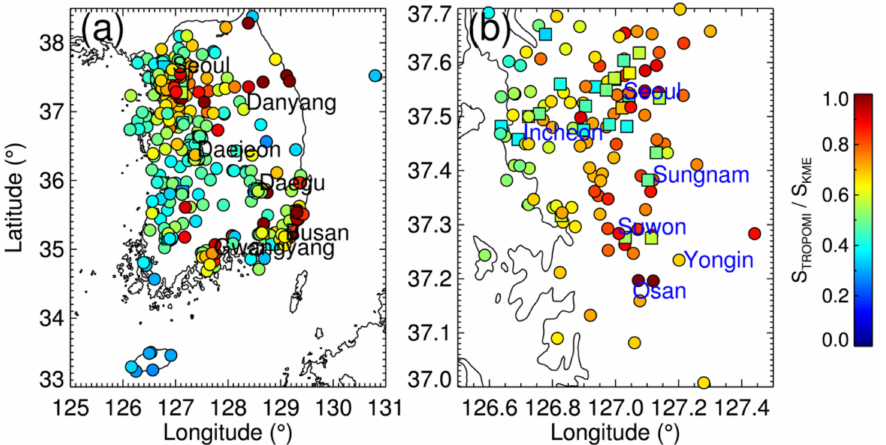
Figure 9. Average ratio of estimated surface NO 2 concentration from TROPOMI to in-situ measure- ments over ( a ) South Korea and ( b ) Seoul metropolitan area, in 2019. Circles represent ambient air-quality monitoring sites away from point sources (e.g., roads with heavy traffic), and squares represent roadside air-quality monitoring